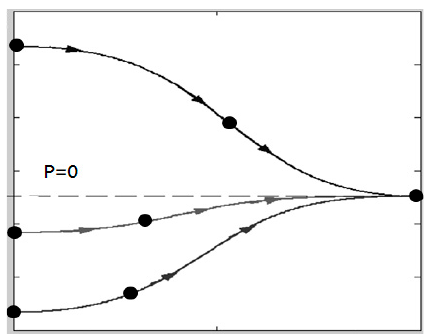
Figure 1. Estimate of the radiation force exerted on WBCs and TCs, respectively, at the same acoustic conditions.